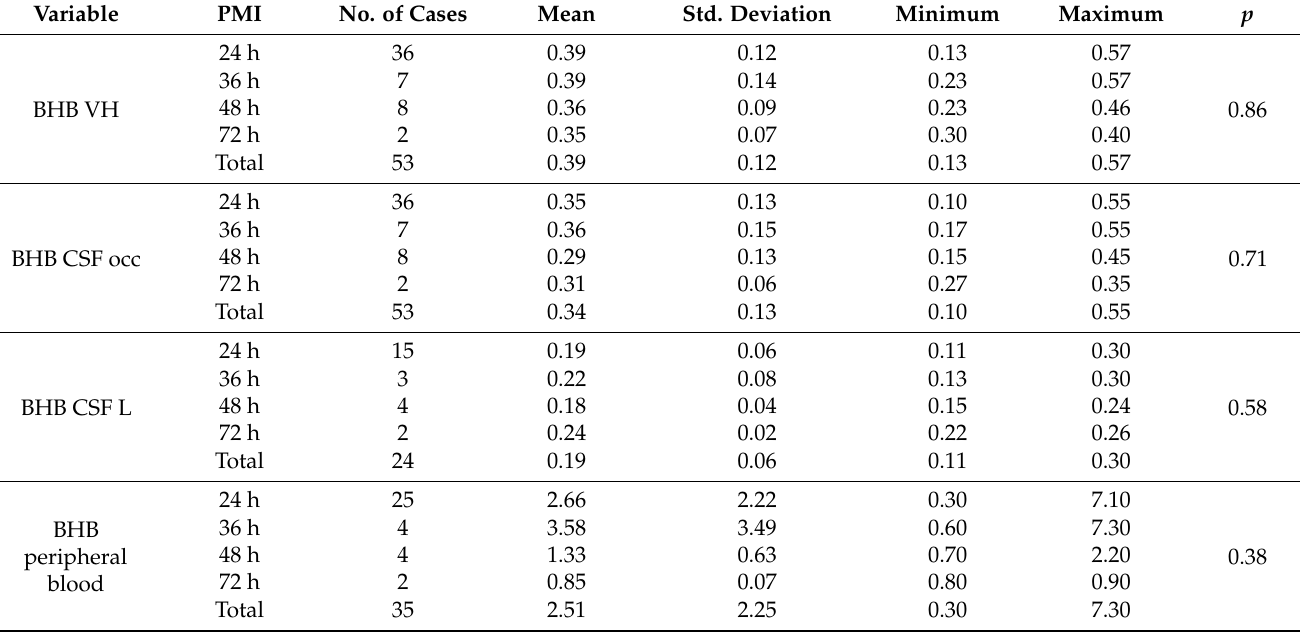
Table 1. Comparison of BHB values by PMI.